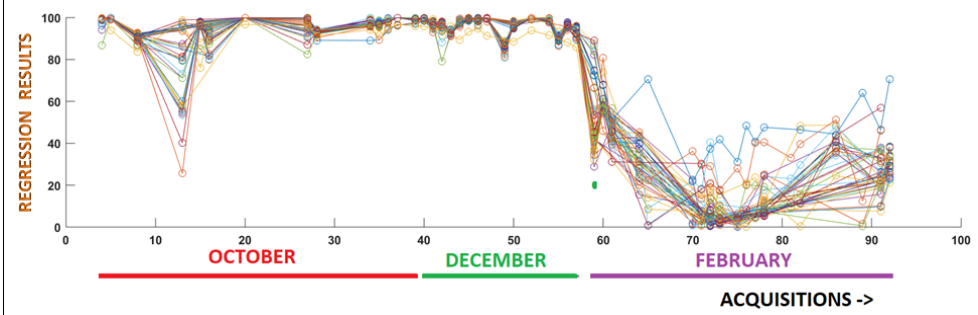
Figure 8: Timeline showing the evolution of the regression values ( 0 : frozen, 100 : non-frozen) for each clean pixel (total 45 ) of lake Sihl on VIIRS data. Each line and circle denote a clean pixel and acquisition respectively. If a pixel is cloudy on an acquisition, the corresponding circle is skipped on the line. The acquisitions on x-axis are shown in the same chronological order as in Figure 2. The outliers at about acquisition 13 are due to the problem shown in Figure 7 b and g. The data gap from 16 December 2016 till 31 January 2017 is skipped. Best viewed on screen.